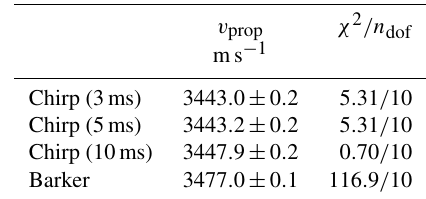
Table 3. Measurement of the propagation speed of sound v prop .